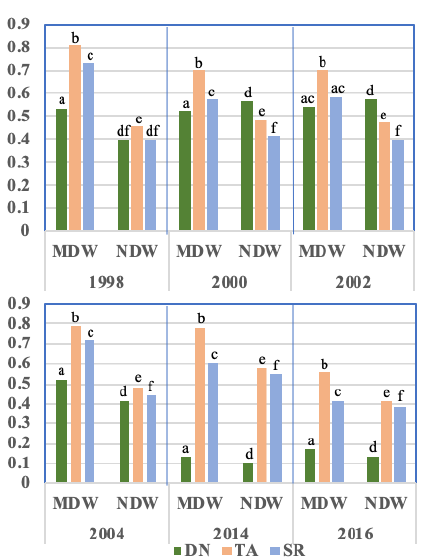
Figure 3. Average values of the Modified Normalized Difference Water Index (abbreviated MDW in the graph) and the Normalized Difference Water Index (abbreviated NDW in the graph) of deep water for three pre-processing levels (DN, TA, SR) across six years. Letters denote significant difference (p <0.05) between pre-processing levels within a given index. Average index values for pre-processing levels were not compared across different indices. Figure 2. Average values of the Vegetation Index (NIR/R), Normalized Difference Vegetation Index (NDVI), and Simple Ratio Index (R/NIR) for predominately Northern Mixed Grass Prairie at three pre-processing levels (DN, TA, SR) across six years. Letters denote significant difference (p<0.001) between pre-processing levels within a given index. Average index values for pre-processing levels were not compared across different indices.